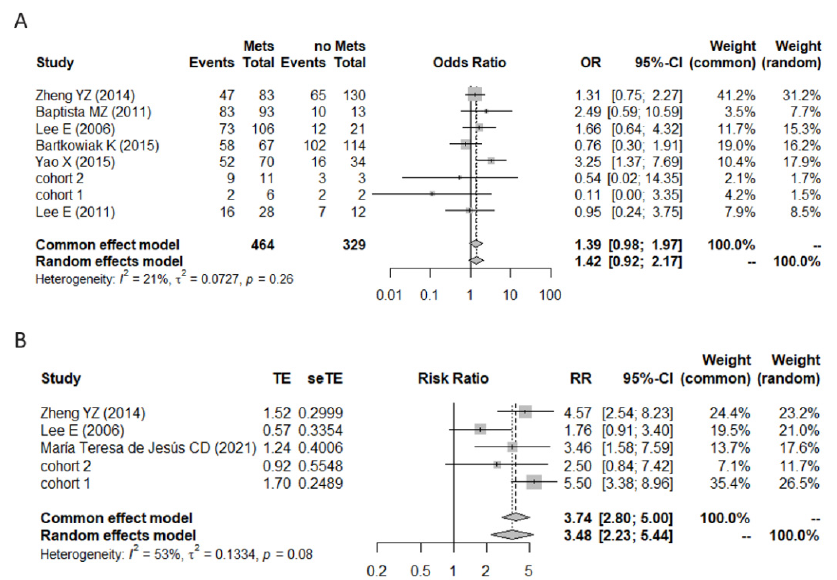
Figure 6. Forest plots for the binary meta-analysis. ( A ) Association between BiP positivity and lymph node metastasis in the studies Baptista, M.Z. (2011) [6], Bartkowiak, K. (2015) [42], Lee, E. (2006) [41], Lee, E. (2011) [48], Yao, X. (2015) [5], Zheng, Y.Z. (2014) [10], cohort 1 and cohort 2.; ( B ) Association between BiP positivity and recurrence-free survival [RFS] in the studies Lee, E. (2006) [41], Maria Teresa de Jes ú s, C.D. (2021) [46], Zheng, Y.Z. (2014) [10], cohort 1 and cohort 2. Individual study estimates of crude odds ratios and 95% confidence intervals (CI). Due to heterogeneity (I2), only random effects estimates were considered. Error bars indicate confidence